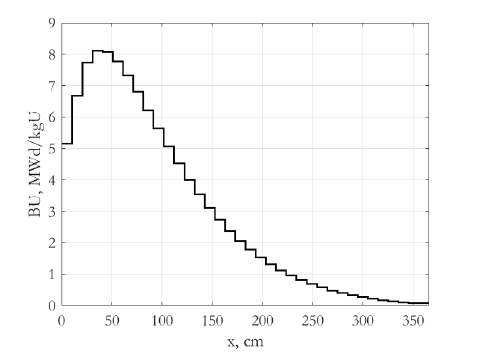
Figure 1: Burnup Axial